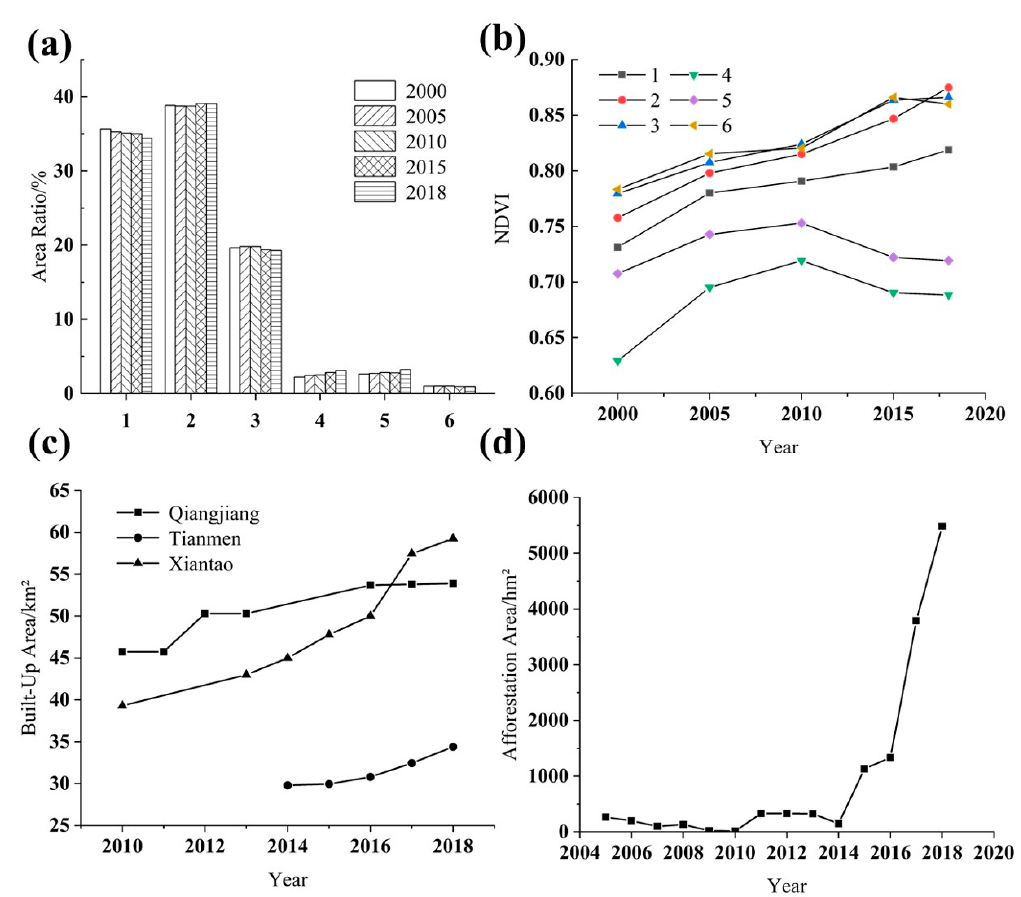
Figure 9. The effects of human activities on NDVI: ( a ) the trend of the land use change, ( b ) the trend of NDVI change corresponding to different land-use types, ( c ) the built-up area in the downstream, ( d ) the afforestation area in the Shennongjia Region.